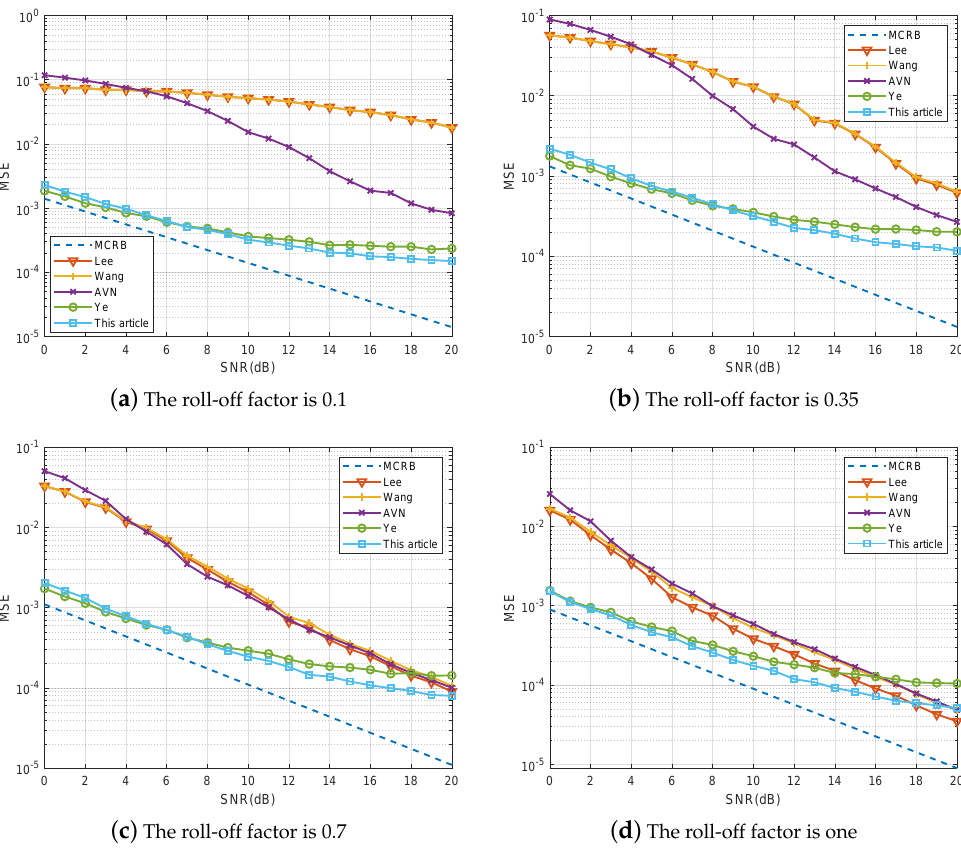
Figure 7. Simulation of the timing error estimation algorithm under different roll-off factors. If the roll-off factor is set to 0.35, a normalized frequency offset of 0.05 is added,